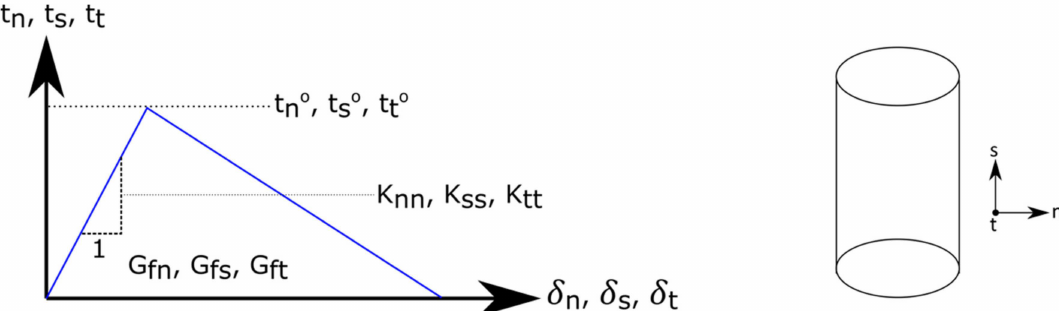
Figure 10. Traction separation law and the directions in the cylindrical coordinate